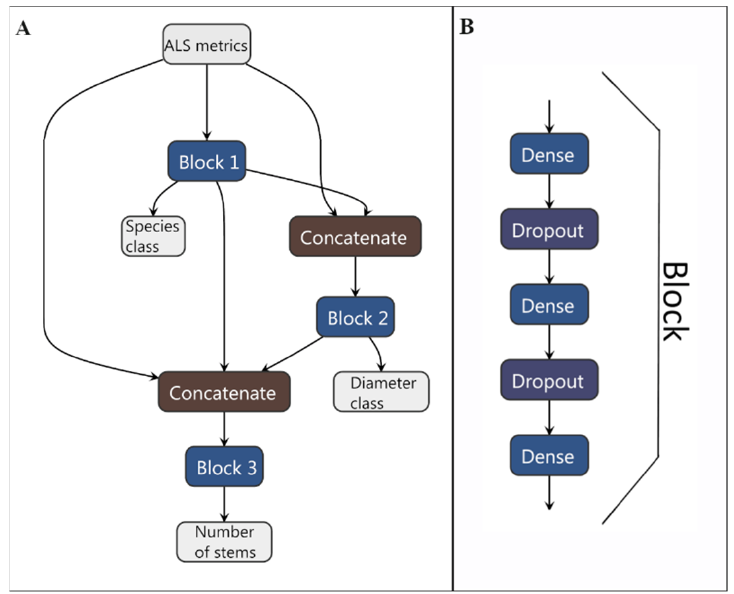
Figure 6. NN architecture: ( A ) overview; arrows represent information flows during NN training and ( B ) block architecture; each block had independent weights and was composed of three dense layers and two dropouts.